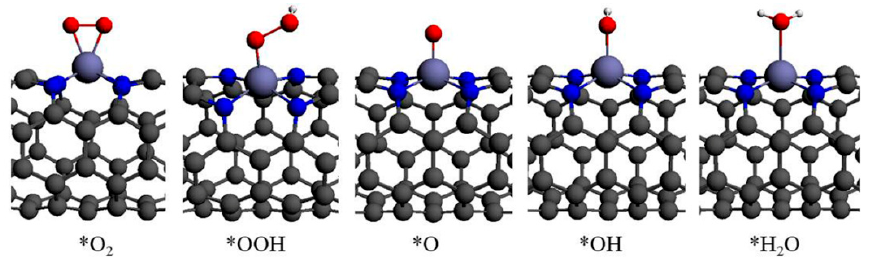
Figure 4. Calculated adsorption con fi gurations of ORR species on Fe − N 4 (4, 4)-9.8.